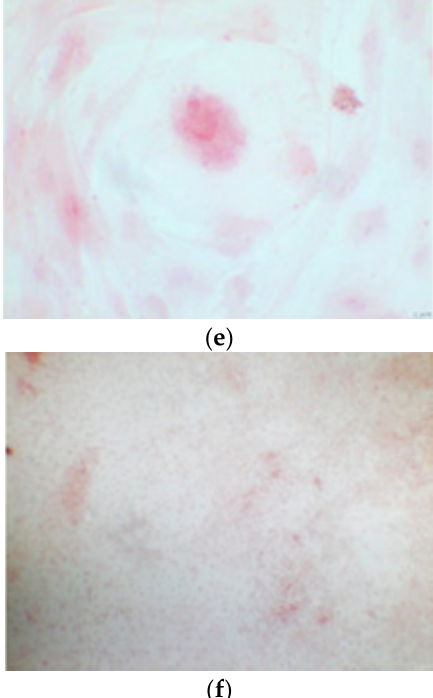
Figure 8. The alizarin test at 21 days confirmed the positivity of samples of calcium deposits, highlighted by red coloration. Compared to 14 days, a more organized structure is evident; we can see this from a smaller red coloration, but precisely because it is more compact and delimited to the cell nucleus. We see CTR2#6 P19 ( a , b ), CTR8#14 P12 – RA ( d , e ), CTR4#5 P20 ( c ).